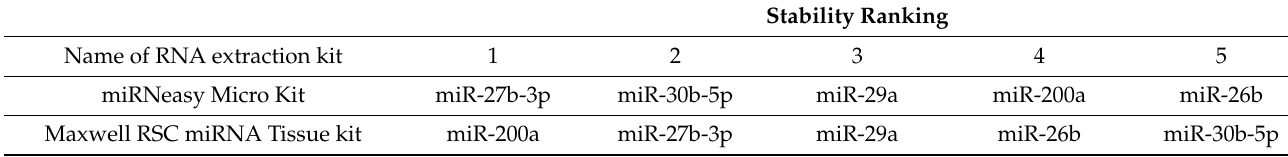
Table 3. Internal control miRNA candidates in bovine milk sEVs stability ranking by RefFinder